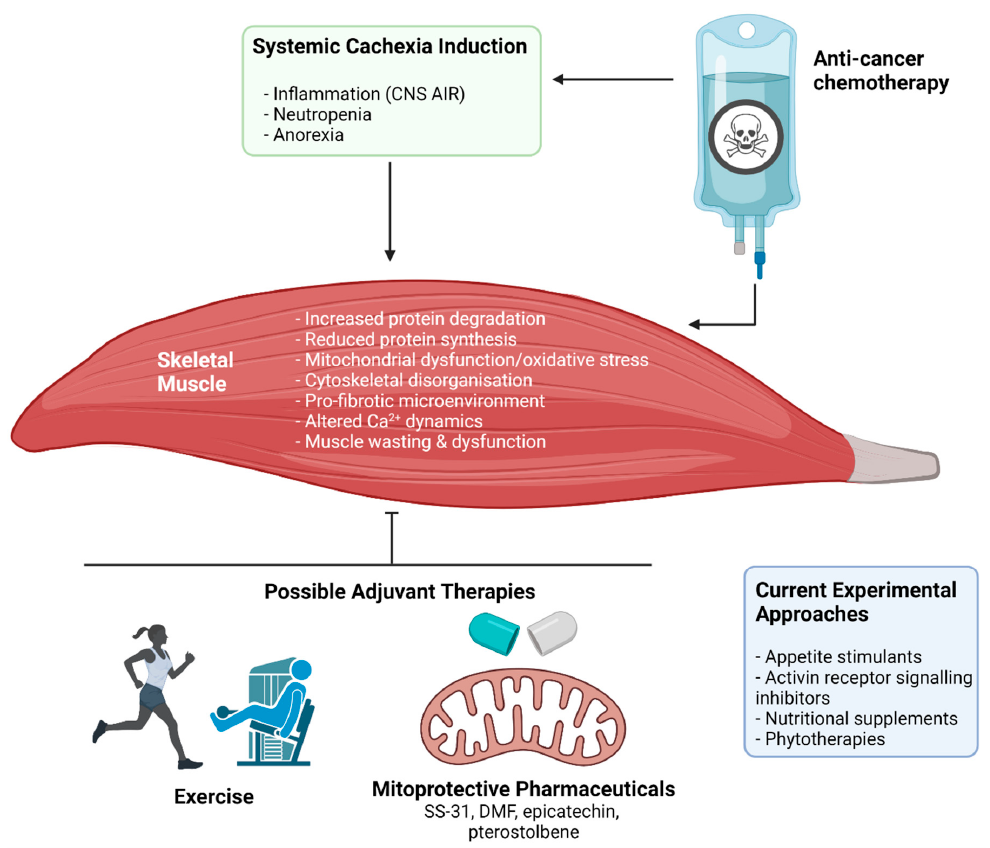
Figure 4. The impact of anti-cancer chemotherapy treatment on cachectic myopathy and possible protective therapeutic interventions. Broadly, chemotherapeutic agents used in clinical cancer treatment can both directly and indirectly target skeletal muscle through induction or amplification of systemic cachexia. The result is the initiation of a wasting and dysfunction program within skeletal muscle, involving: increased muscle protein degradation, reduced protein synthesis, mitochondrial dysfunction and oxidative stress, cytoskeletal disorganisation and reduction of key cytoskeletal proteins that stabilise the muscle membrane, pro-fibrotic signalling within the extracellular matrix, and altered calcium (Ca2+) dynamics. The result is muscle wasting and dysfunction that leaves patients weak and fatigued, which affects their capacity to undertake activities of daily living and reduces quality of life. Several potential therapeutic approaches are currently being investigated to protect against or treat these symptoms including appetite stimulants, activin receptor signalling inhibitors, nutritional supplements, and phytotherapies. Novel therapeutic strategies could include exercise and mitoprotective compounds (e.g., SS-31, BGP-15, dimethyl fumarate (DMF), epicatechin, and pterostilbene). Abbreviations: CNS AIR: central nervous system acute illness response. Created with biorender.com (accessed on 6 July